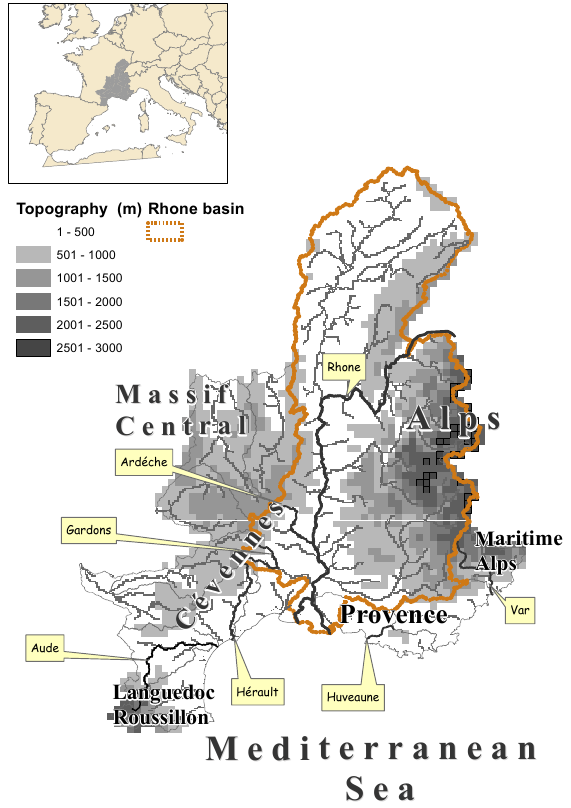
Fig. 1. Topographical map of the area of study. Featuring the Rhˆone basin and other Mediterranean basins of France.